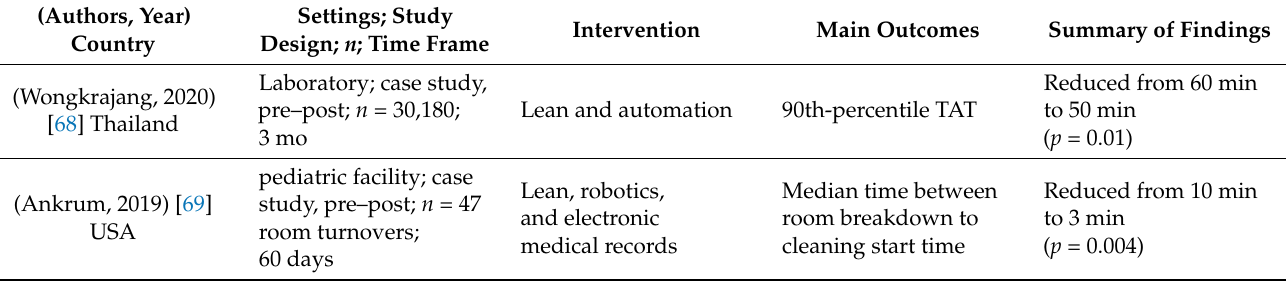
Table 2. TAT outcomes of LH interventions supported by DTs.